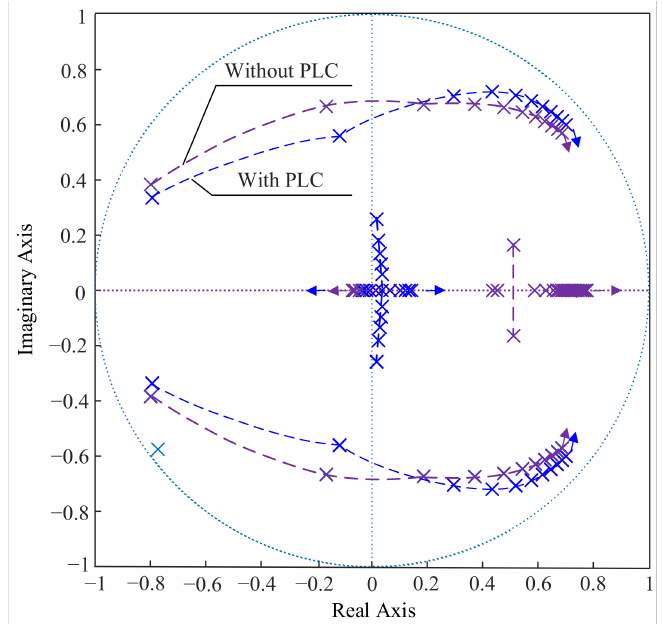
Figure 17. Closed-loop pole maps with the grid inductance variation [24].